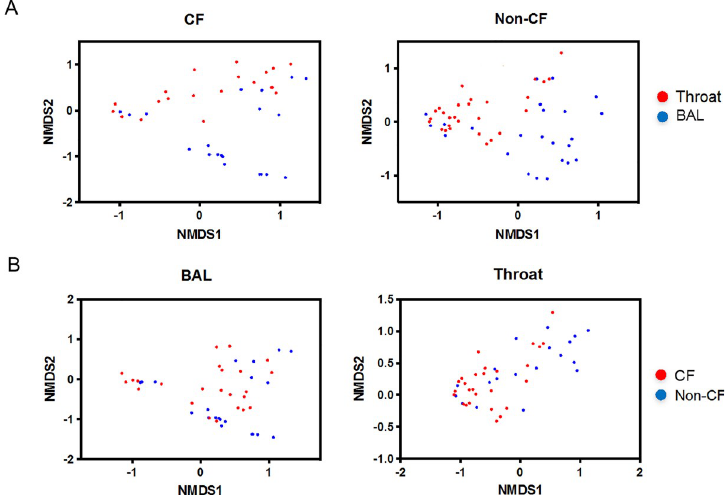
Fig 2. Plots showing clustering of airway microbiome communities. (A) Upper airway and lower airway microbiome of CF (left) and non-CF (right) children represented by nonmetric multidimensional scaling (NMDS) of pairwise weighted Unifrac distances. Weighted UniFrac distance matrices were generated using QIIME v 1.8.0 and visualized via NMDS in the R statistical environment using the vegan package. (B) Lower (left) and upper airway (right) microbial communities stratified by CF and non-CF status represented by NMDS of pairwise weighted Unifrac distances. Statistical significance of clustering by group was determined using PERMANOVA. https://doi.org/10.1371/journal.pone.0222323.g002 (Fig 6B). For both CF and non-CF controls, upper airway metagenomes were enriched with genes involved in amino sugar and nucleotide sugar metabolism, fructose and mannose metabolism, galactose metabolism, starch and sucrose metabolism, and phosphotransferase system, whereas genes associated with amino acid biosynthesis, degradation and metabolism, and fatty acid biosynthesis were overrepresented in lower airway metagenomes (S1 Fig).